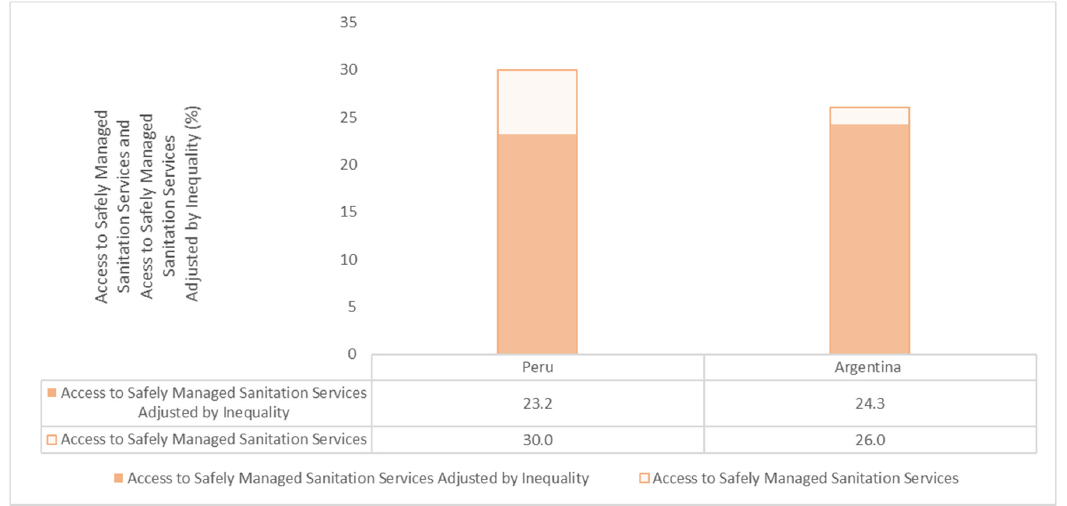
Figure 8. Peru and Argentina—access to safely managed sanitation services and access to safely managed sanitation services adjusted by inequality. Source: Own elaboration based on census microdata from the IPUMS-International Project [25].